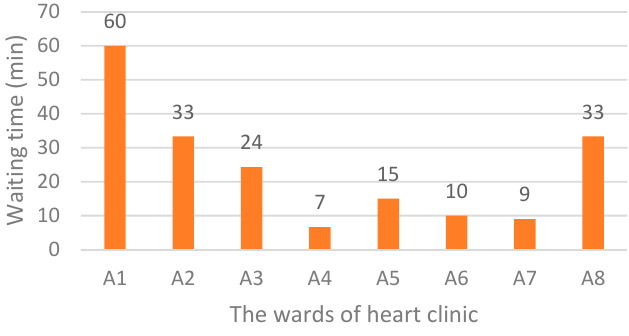
Figure 8. Waiting times after the first scenario implementation.